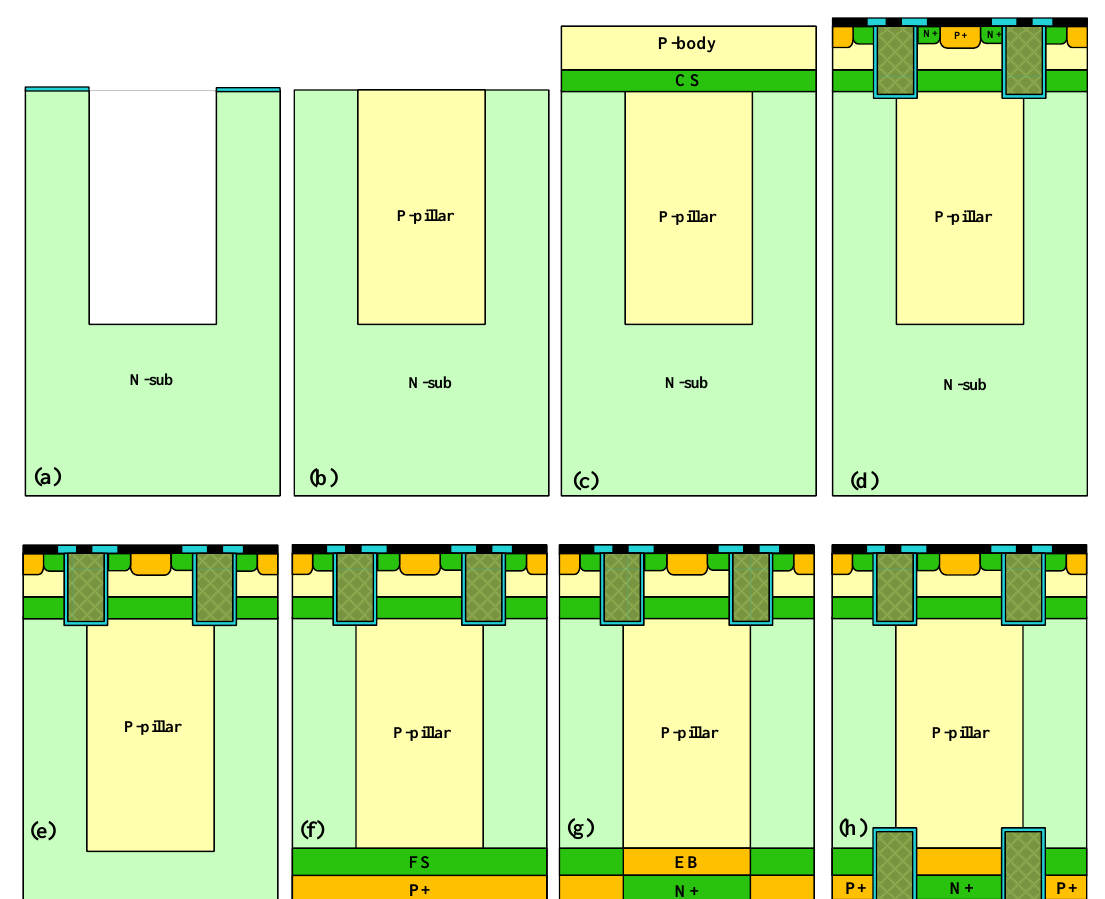
Figure 10. The key fabrication process steps of the SJ-RC-IGBT. ( a ) Deep trench etching based on reactive ion etching, ( b ) trench refilling by anisotropic epitaxial growth, ( c ) epitaxial growth of CS layer and P-body, ( d ) forming trench MOS structure and electrode, ( e ) back thinning, ( f ) forming FS layer and P+ collector by backside implantation, ( g ) forming EB layer and N+ collector by backside implantation, and ( h ) forming backside trench and electrode.